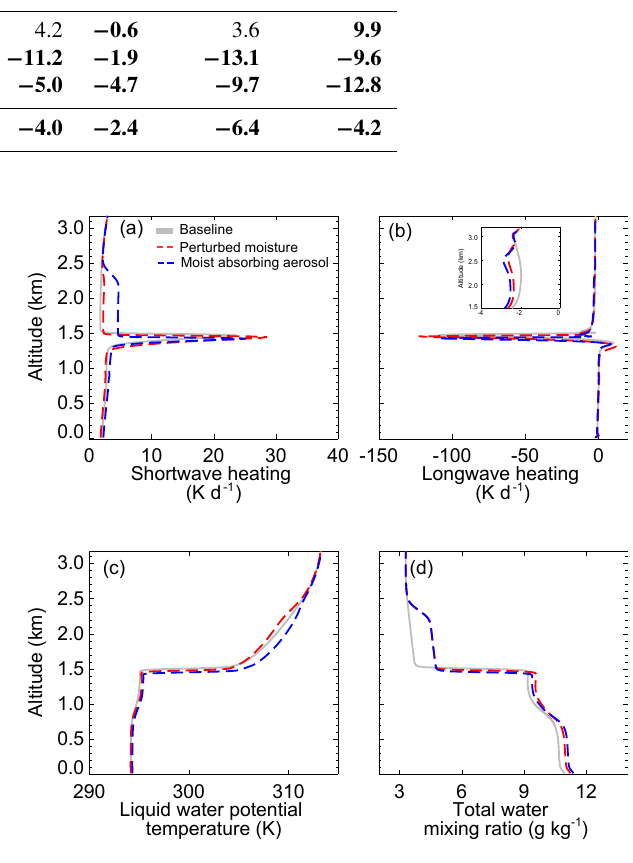
Figure 8. Horizontally averaged profiles of (a) SW heating rate, (b) LW heating rate, (c) liquid water potential temperature, and (d) total water mixing ratio averaged over hours 35–37 for the lightly drizzling baseline ensemble ( N a , sulfate = 150mg − 1 ) (gray and black), perturbed moist case (red), and perturbed moist ab- sorbing aerosol case (blue). The subpanel in (b) shows the diurnal- average LW heating rate profile on day 1 from 1.5 to